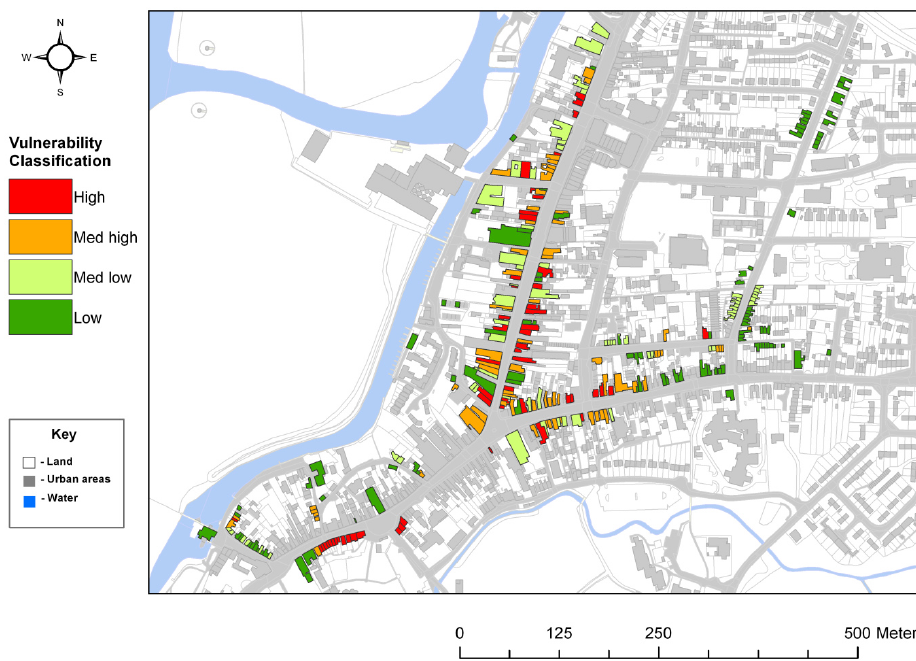
Fig. 10. Vulnerability classification map of Tewkesbury.